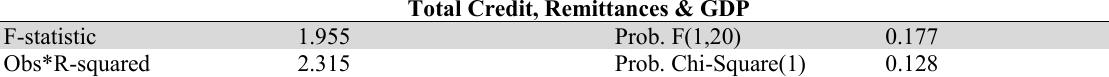
Breusch-Godfrey Serial Correlation LM Test